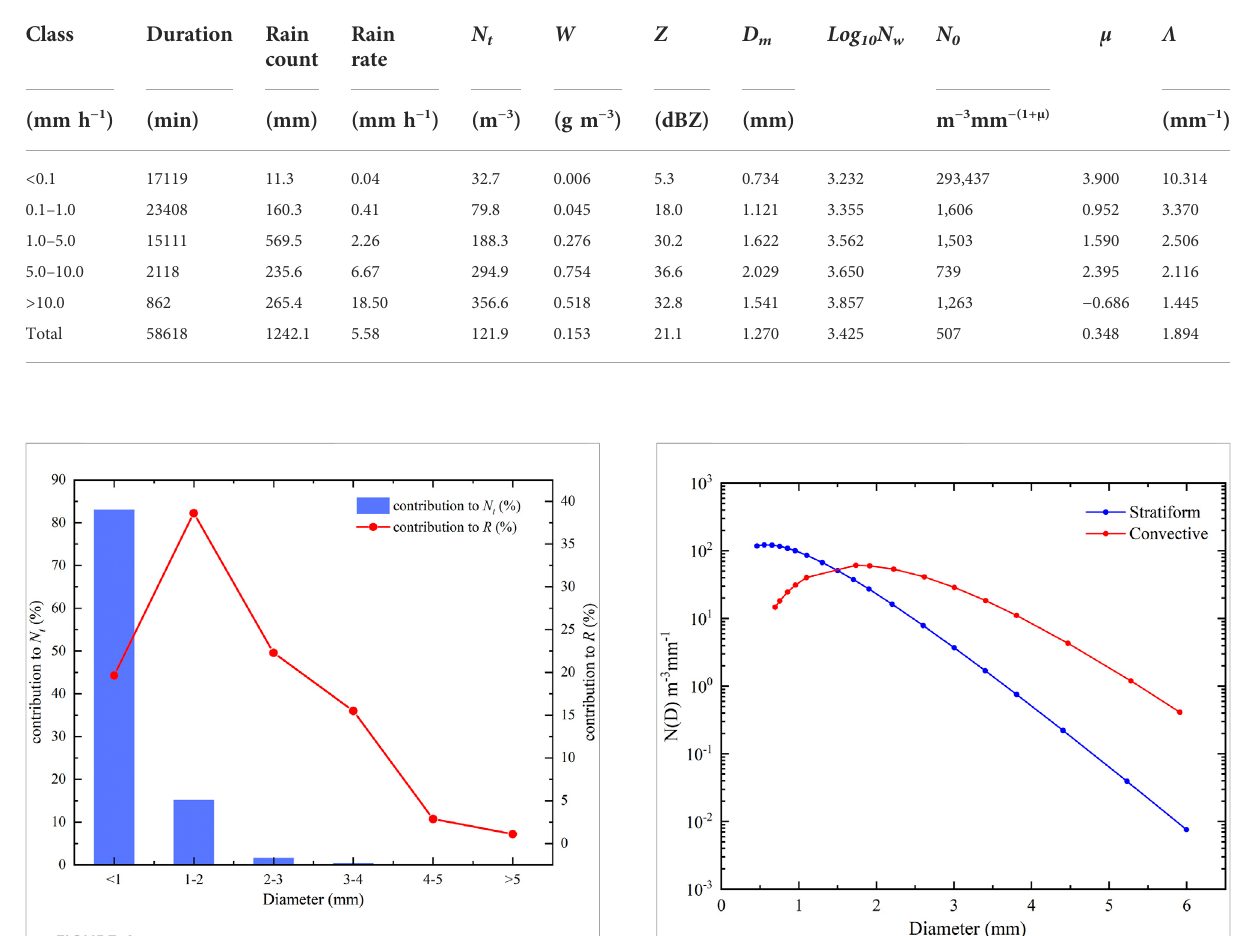
TABLE 2 Integral rain parameters obtained from the average raindrop size distribution for the fi ve precipitation rate classes and the total data.